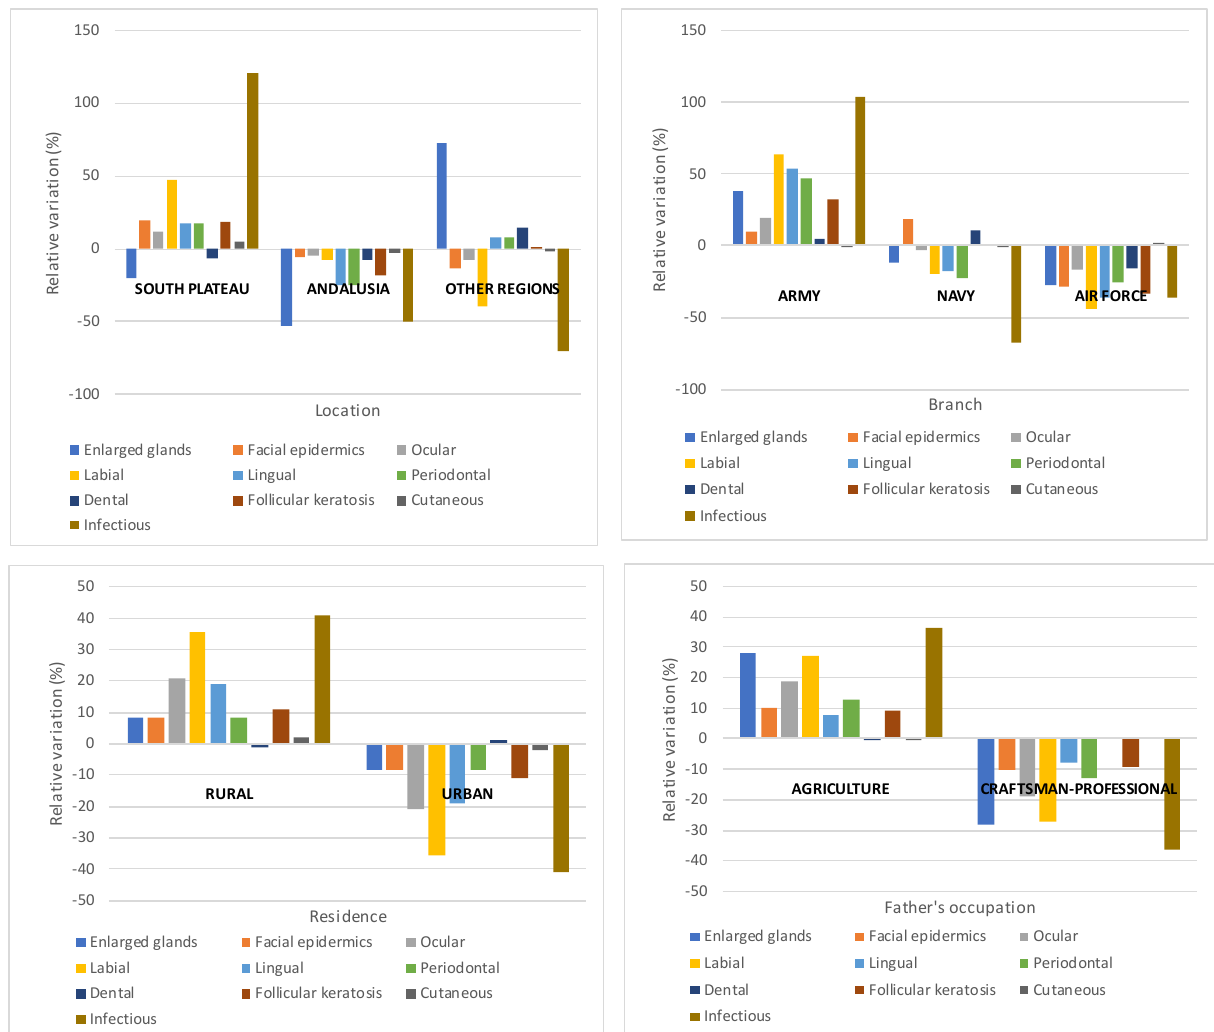
Figure 4. Relative variation of diseases in the detailed medical check-up, according to tabulation variables. Table 8. Detailed medical check-up: Statistical association analysis between variables.